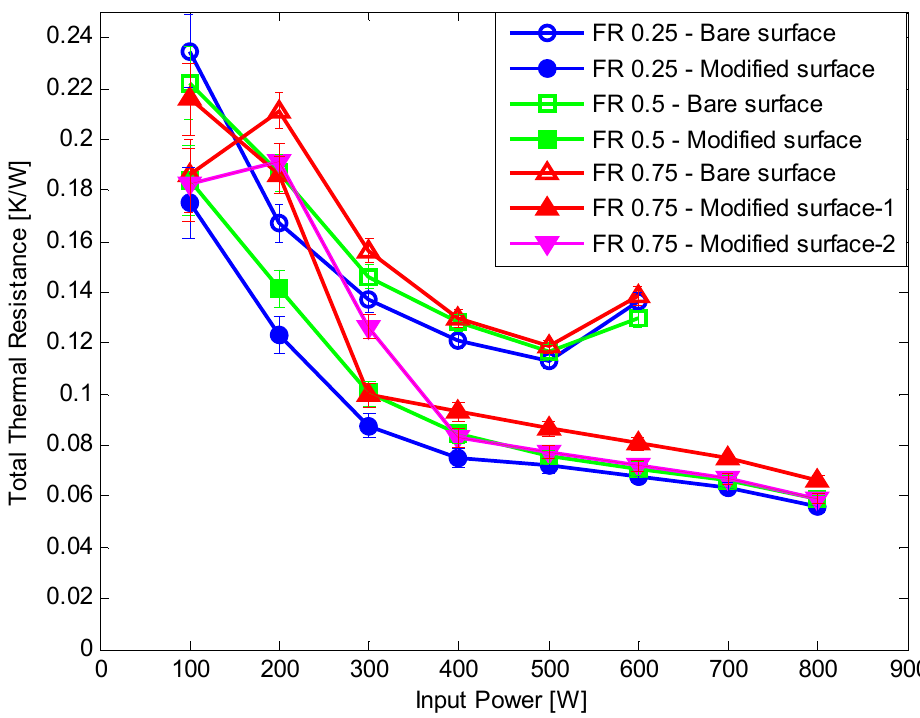
Figure 9. Comparison of the total thermal resistance of bare and hydrophilic surfaces.